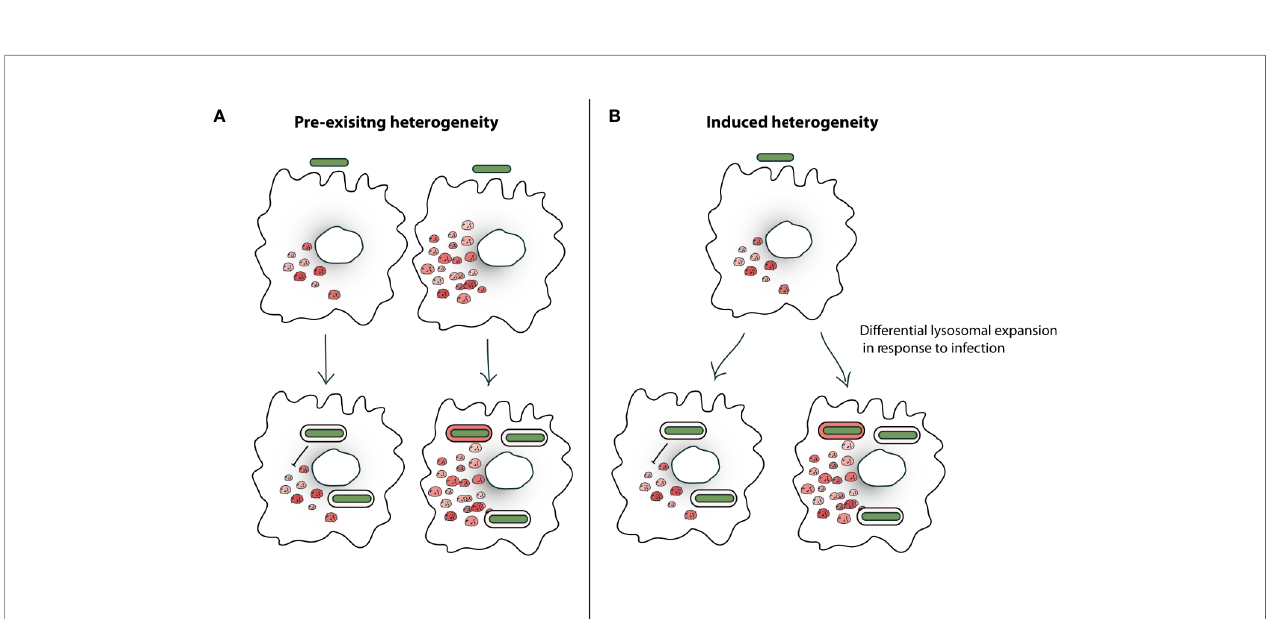
FIGURE 5 | Lysosomal heterogeneity in fl uencing intracellular Mycobacterium tuberculosis (Mtb) traf fi cking. (A) Heterogeneity in lysosomal targeting of pathogens in the host cells could be driven by pre-existing heterogeneity of host cells where some cells intrinsically have more lysosomes and are more ef fi cient in traf fi cking Mtb (green) to lysosomes (red), or it could also be driven by pathogen diversity, where some pathogens cells are less capable of resisting lysosomal delivery. (B) Other model proposes the idea of induced heterogeneity where post-infection the heterogeneity is induced in the host and pathogen e.g. lysosomal levels and lysosomal delivery of Mtb in cells becomes heterogeneous. Existing literature suggests that these events are not mutually exclusive and pre-existing heterogeneity in the pathogen cells can induce diversity in the host cell response. Similarly, heterogeneity of the host cells can generate diversity in the pathogens upon